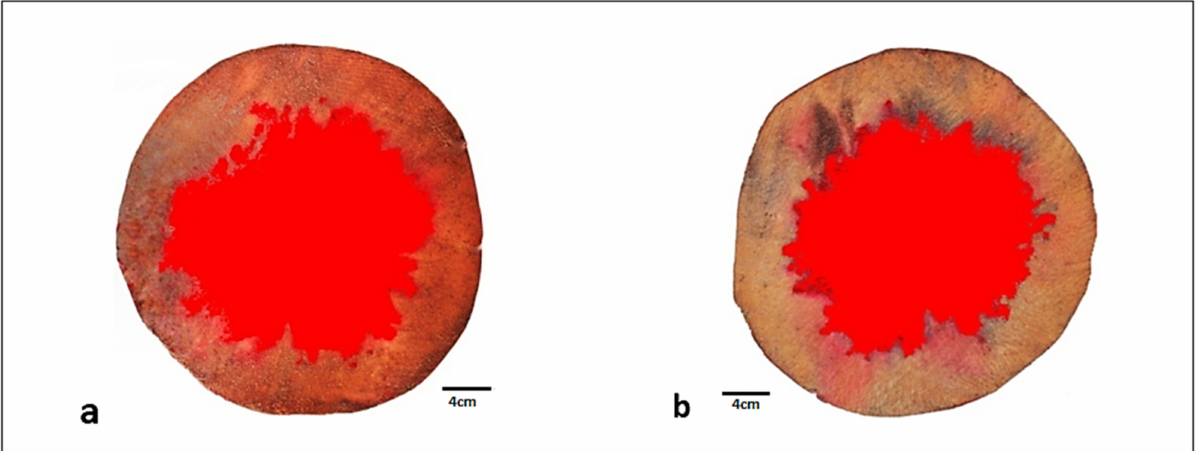
Figure 5. Images of transversal section of the stems. The colored area represents the active conductive